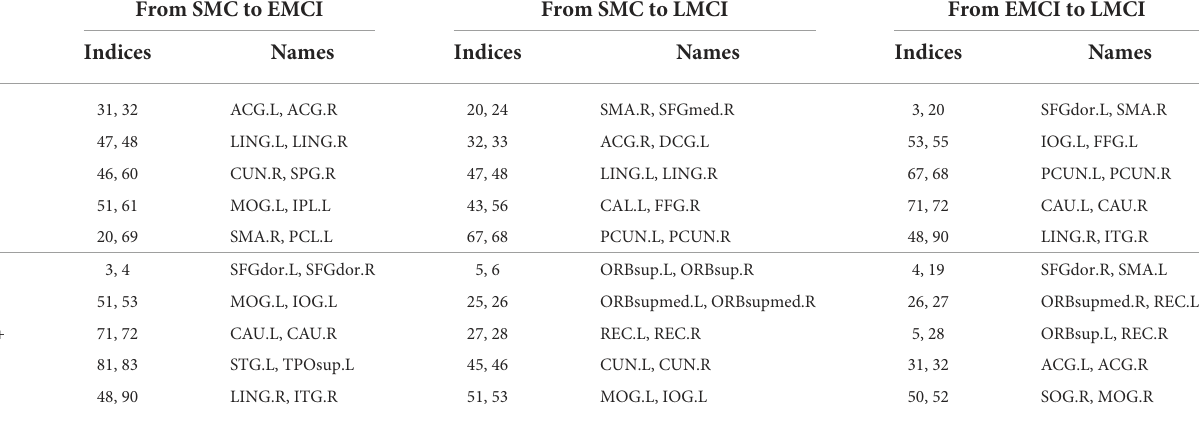
TABLE 2 The top 10 significant altered connections estimated from the generated FBNs in SMC vs. EMCI, SMC vs. LMCI, EMCI vs. LMCI using AAL90 template ( − means reduced connections, + means increased connections). From SMC to